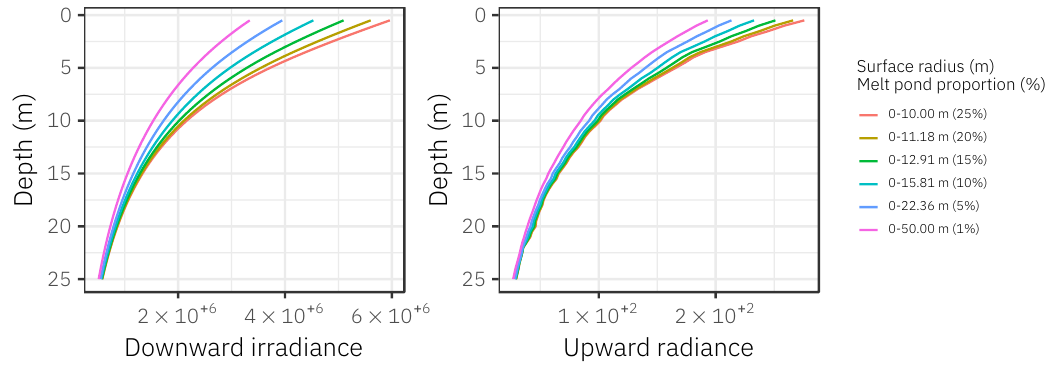
Figure 7. Simulated reference downward irradiance and upward radiance profiles ( E d ( z ) , L u ( z ) in relative units) for six different areas with varying proportions of the surface occupied by the melt pond (see Figure 1). Note that none of the averaged irradiance profiles show the same subsurface light maxima as observed with in situ data (see Figure 3).